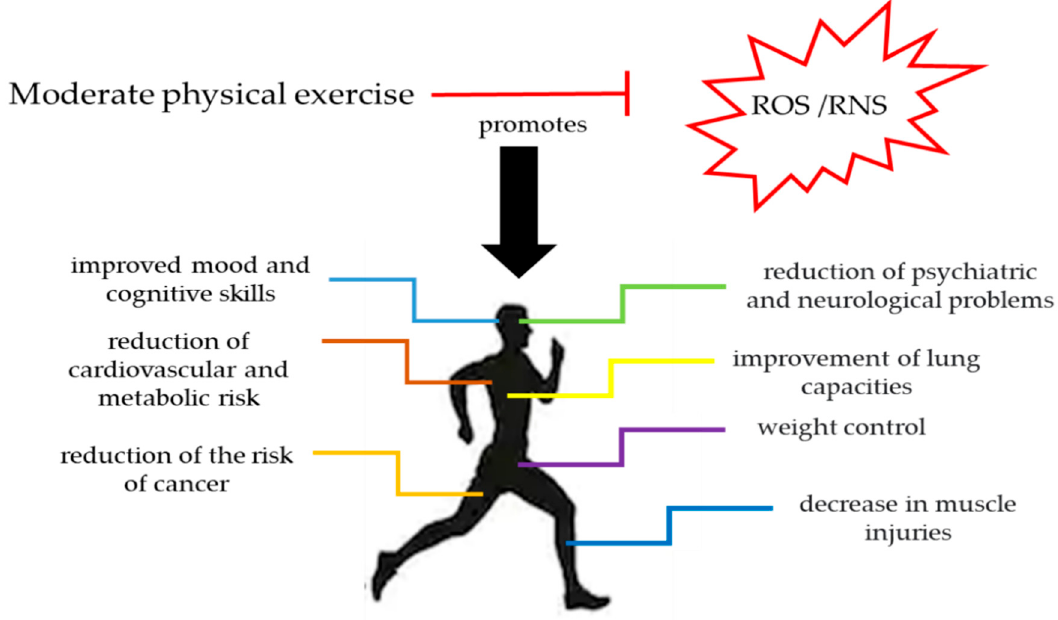
Figure 2. The benefits of moderate physical exercise.